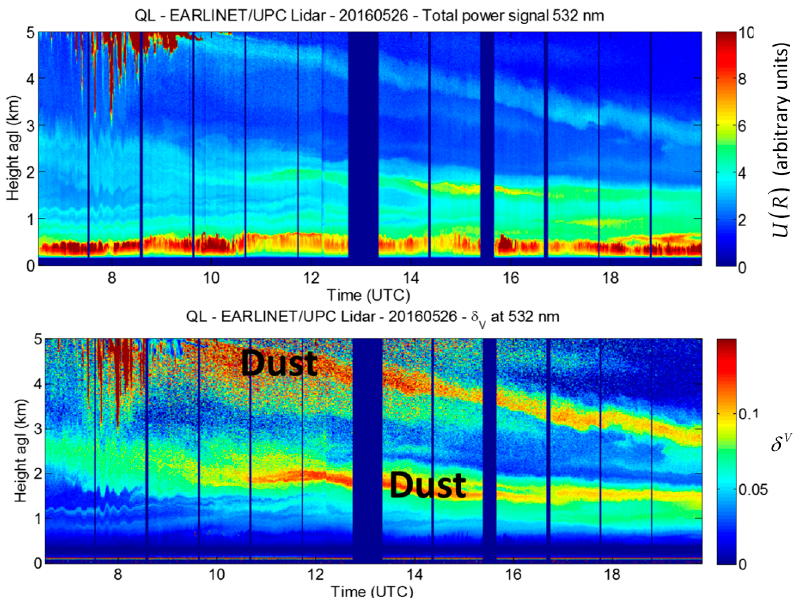
Figure 7. Detection of Saharan dust with depolarization channel with the UPC multi-wavelength lidar during the 26 May 2016 intrusion: ( a ) Range-corrected total power as a function of time and height above ground level; ( b ) Volume depolarization ratio as a function of time and height.